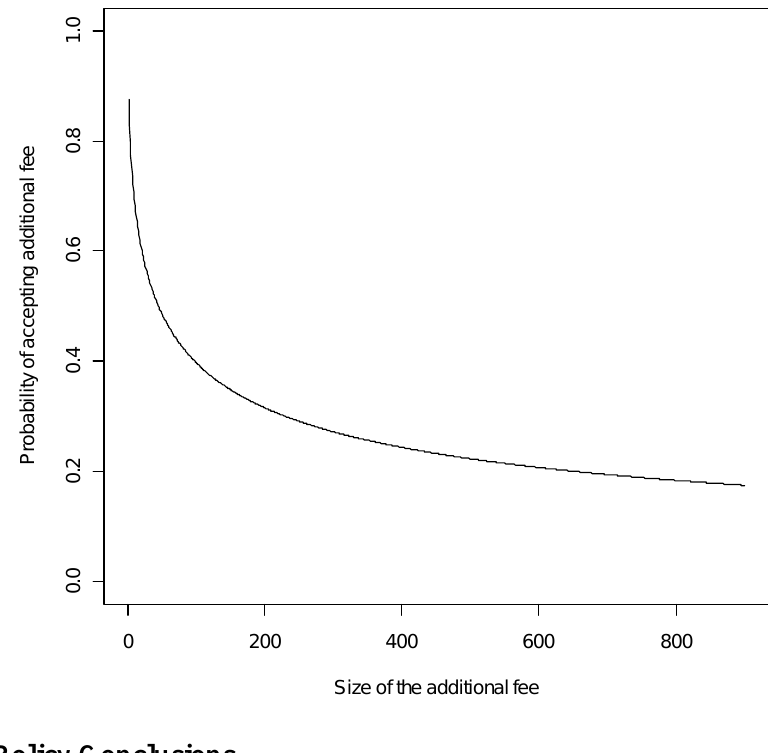
Figure 1. Marginal effect of the size of the additional fee on the probability of